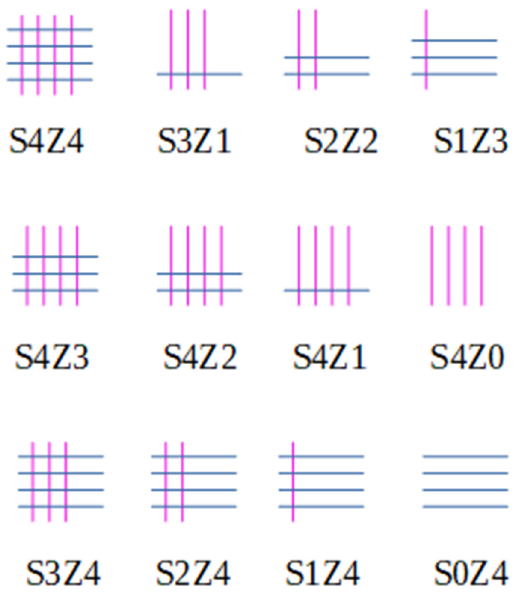
Figure 2. Schematic showing the definition of different systems. Each vertical line in magenta shows free straight channels while blue horizontal lines show free zigzag channel. The blocked channels are marked by an absence of the corresponding line. S4Z4 corresponds to the unmodified silicalite with no pore blocked with methane.